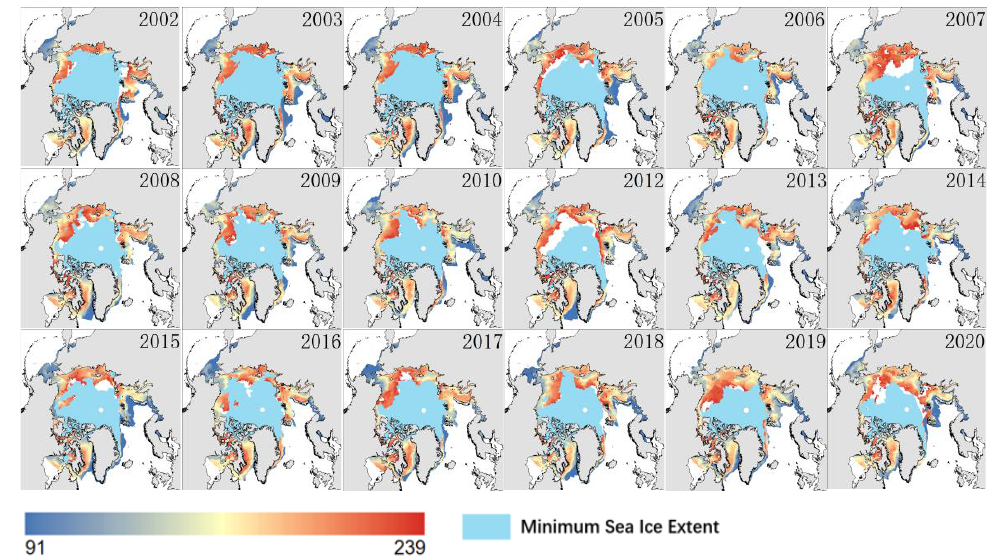
Figure 9. Spatial distribution of Arctic sea ice complete melt dates (DoY) from 2002 to 2020. The Arctic freezes from early September to the end of December (Figure 10), around Table 6. The DoY of Arctic sea ice freeze-up from 2002 to 2020. DoY 245–365 (Table 6), and the onset of the freeze, on average, occurs in late October, around DoY 296 or October 23. The time to complete freeze is in early November, on DoY 305 or around 1 November. In the Arctic, the Beaufort Sea freeze-up occurs first on September 23 (DoY 266) and reaches full freeze the fastest on DoY 277. The Laptev Sea, East Siberian Sea, Northwest Passage, and Greenland Sea freeze-up and complete freeze occur at the same time (Table 7), starting to freeze on DoYs 282, 283, 283, and 287, respectively, and completely freeze on DoYs 292, 291, 295, and 297, respectively (Figure 11). The Kara Sea and Chukchi Sea freeze-up occurs on DoYs 305 and 303, respectively, and reaches full freeze on DoYs 315 and 309. In the Norwegian Sea and Baffin Bay, on either side of Greenland, freeze-up occurs on DoYs 313 and 319, respectively, and they reach full freeze on DoYs 317 and 327. The Barents Sea was the last to begin freezing, on November 19 (DoY 323), and the last to reach full freeze, on DoY 329.